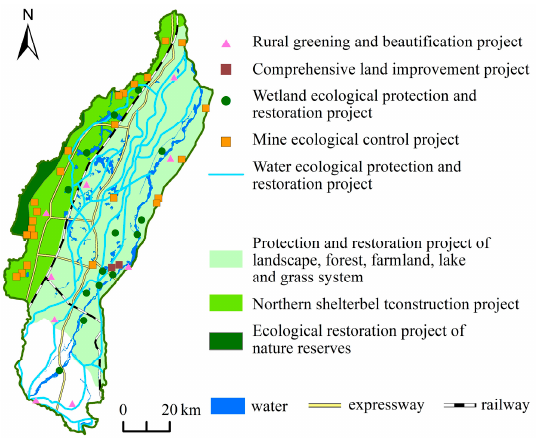
Figure 7. The layout of key projects for improving the ecological environment in the Yinchuan metropolitan region. Key ecological improvement projects were used to verify the rationality of corridors and pinch points.